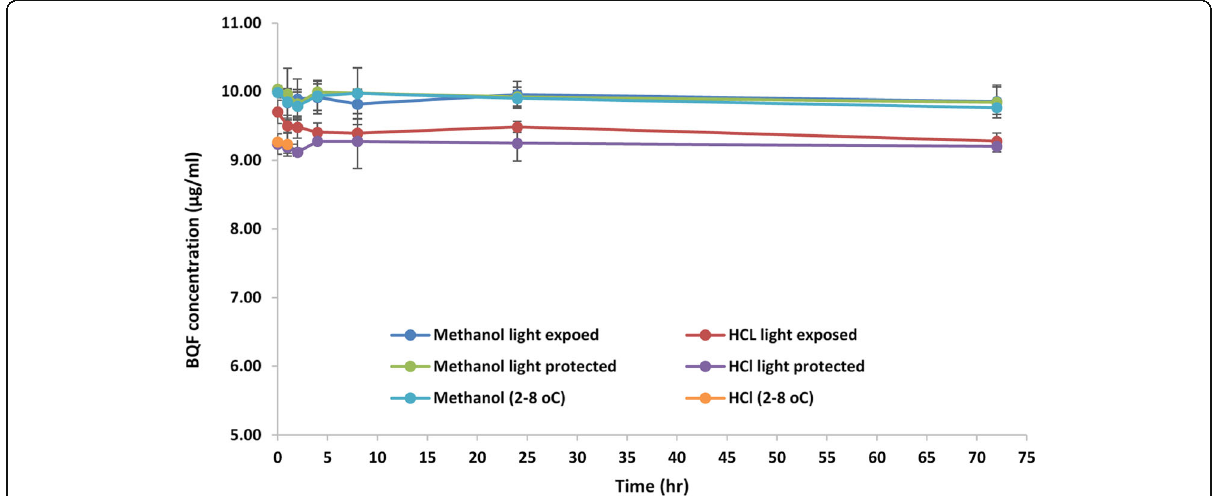
Fig. 5 BQF stability in 0.01 N HCl and methanol at RT and 2 – 8 °C temperature under normal daylight light exposure and light